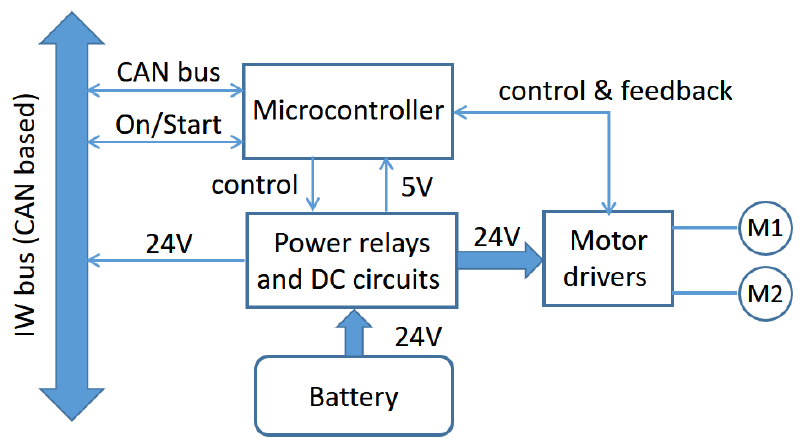
Figure 6. Elements and functions of the motor node. Connections to signals in IWBus are also